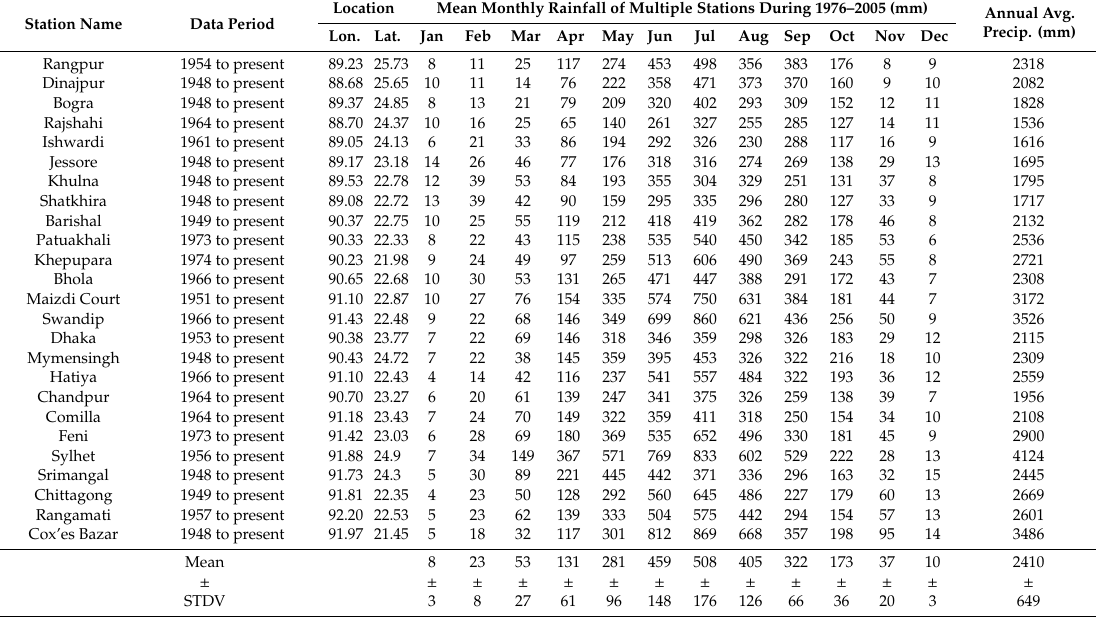
Table 1. Mean monthly and annual rainfall at various stations in